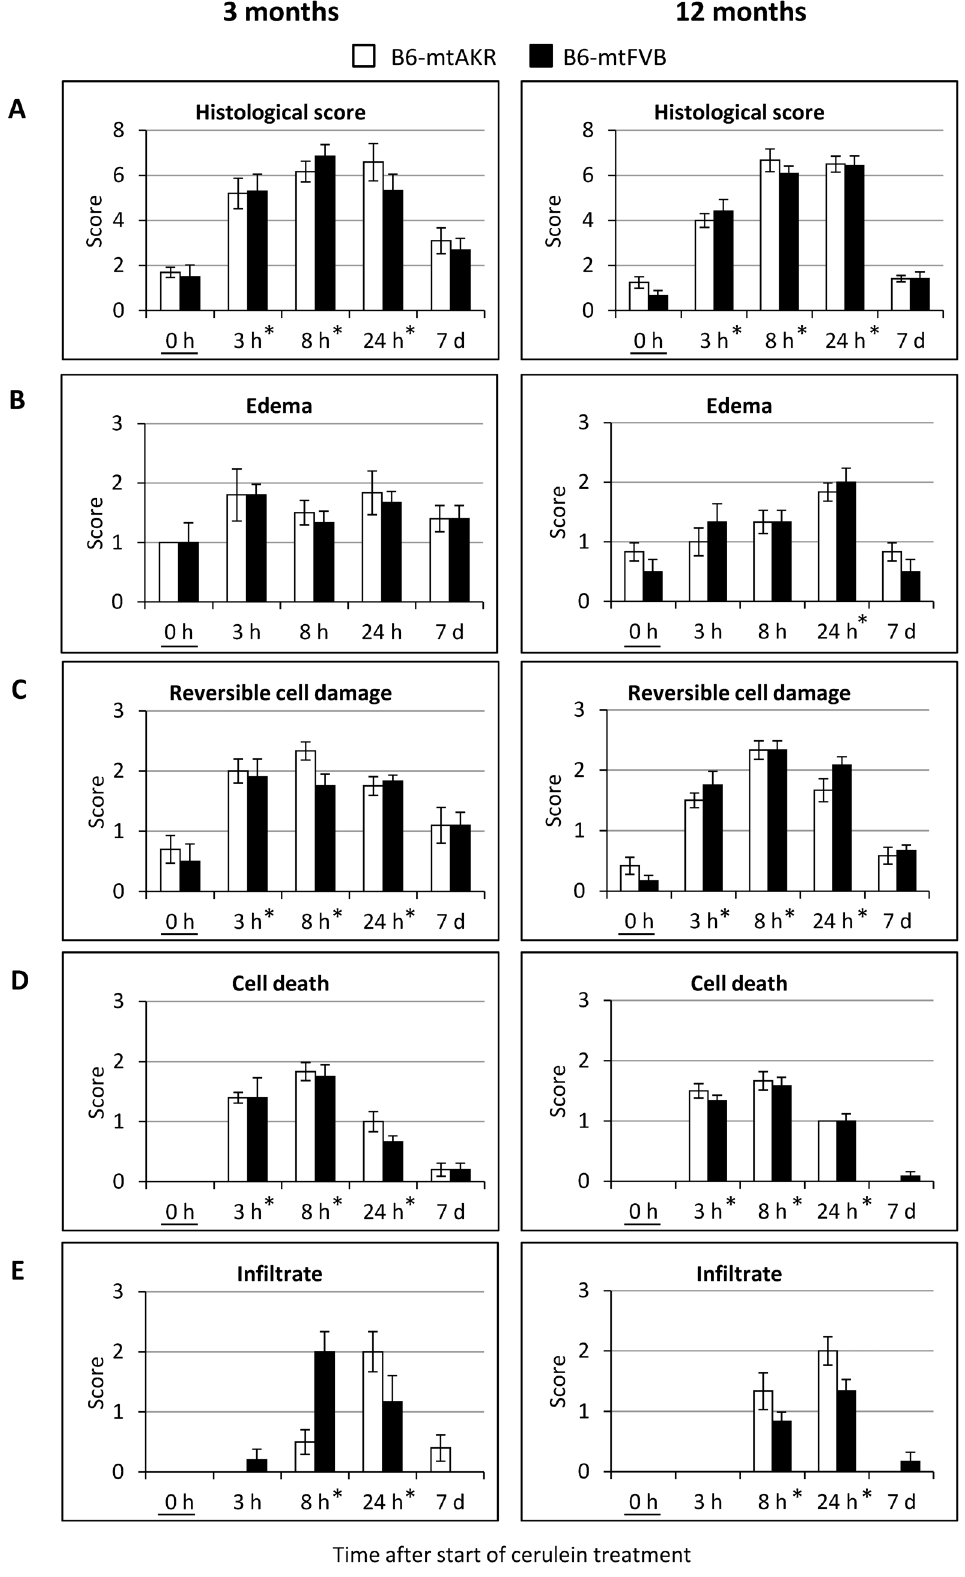
Figure 2. Evaluation of cerulein-induced pancreatic tissue damage in B6-mtAKR and B6-mtFVB mice. Three months and 12-month-old B6-mtAKR and B6-mtFVB mice were treated with cerulein as indicated (n=5–6 per time point, strain and age group). Pancreatic sections of the mice were stained with H&E and scored as described in the ‘‘Materials and Methods’’ section. The total histological score shown in (A) represents the sum